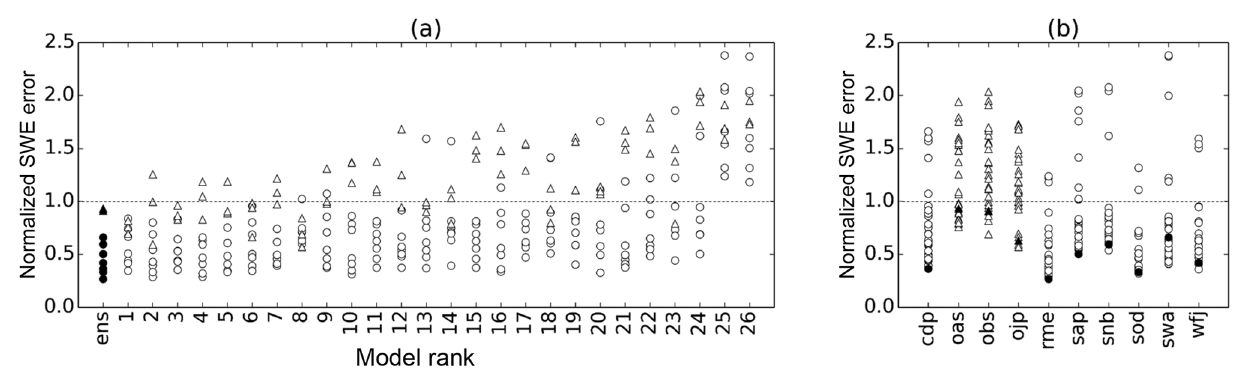
Figure 4. Normalized root mean square SWE errors for the 26 non-ensemble models in Table 1 returning a single simulation for each site (white symbols) and the 26-model ensemble mean (black symbols), with simulations identified by circles at open sites and triangles at forested sites. (a) Models ranked according to their average error for all sites. (b) Errors for all models at each site (for abbreviations see Fig.